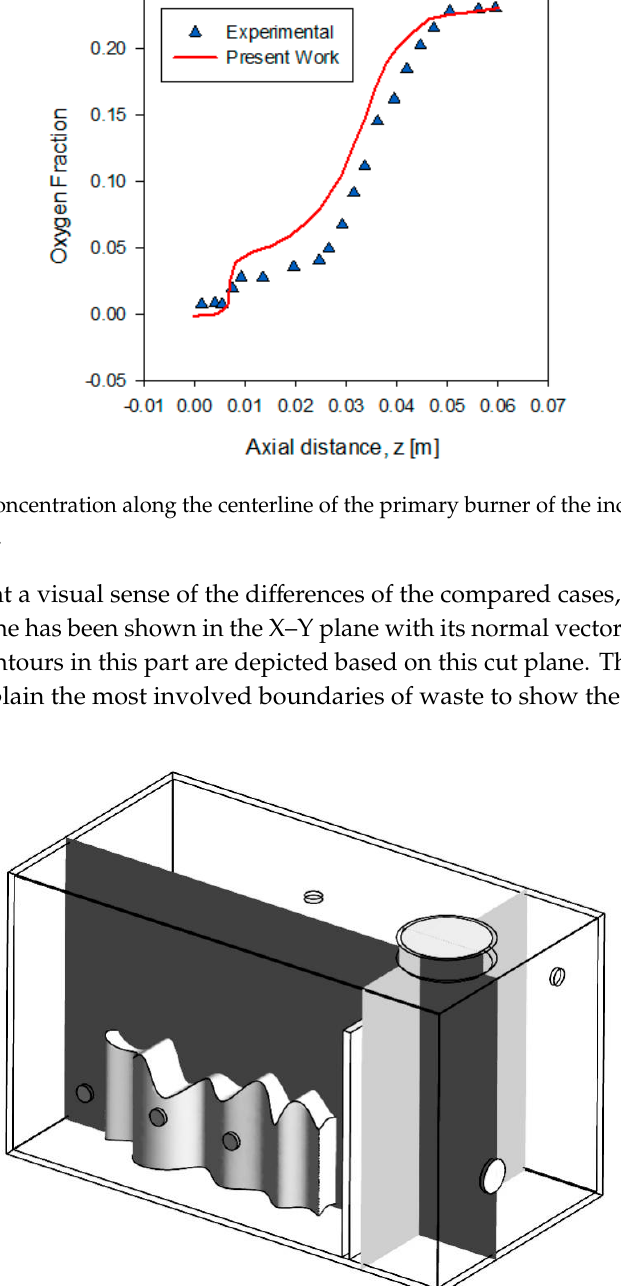
Figure 5. A validation for 3 different mesh element numbers with temperature variation along the incinerator length.